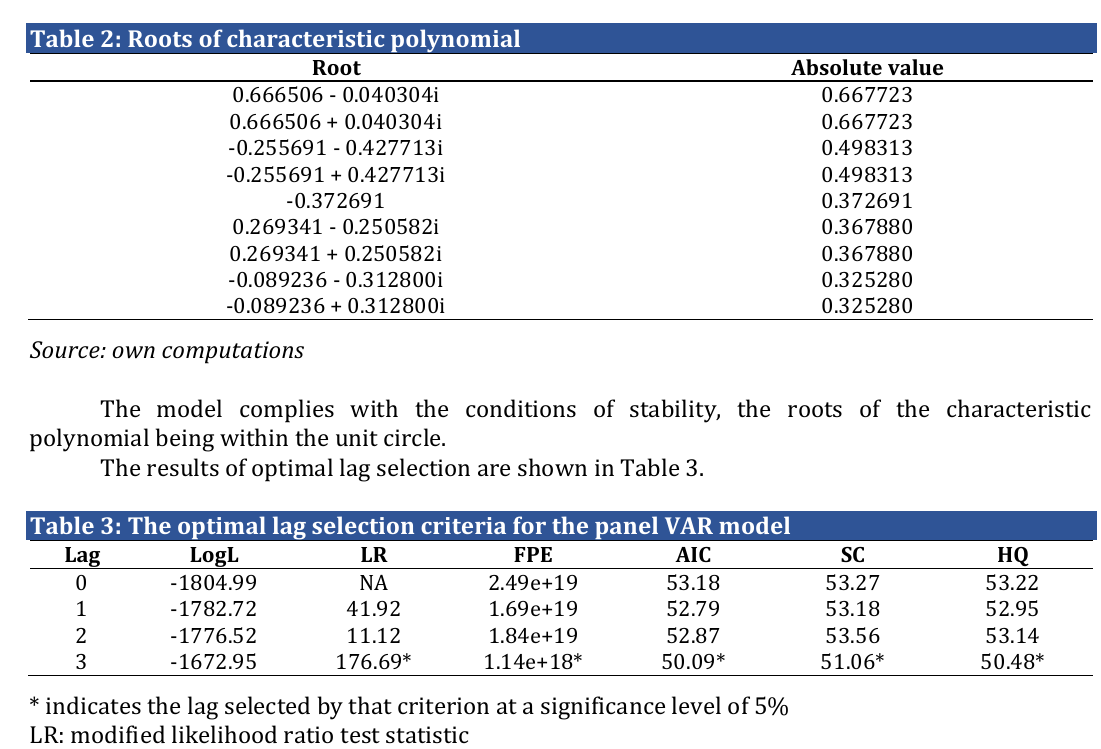
* indicates the lag selected by that criterion at a significance level of